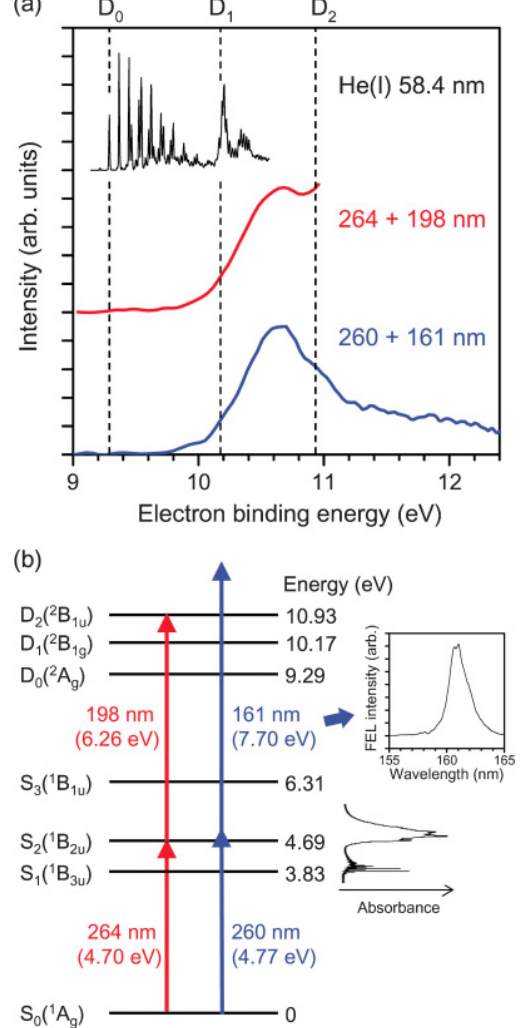
Figure 7. ( a ) PKED in He(I) photoelectron spectroscopy of ground-state pyrazine (black). 264-nm pump and 198-nm probe experiment (red) and 260-nm pump and 161-nm probe (blue); ( b ) Schematic energy diagram of the ionization processes. Insets show UV absorption spectrum of pyrazine vapor at room temperature and time-averaged spectrum of VUV